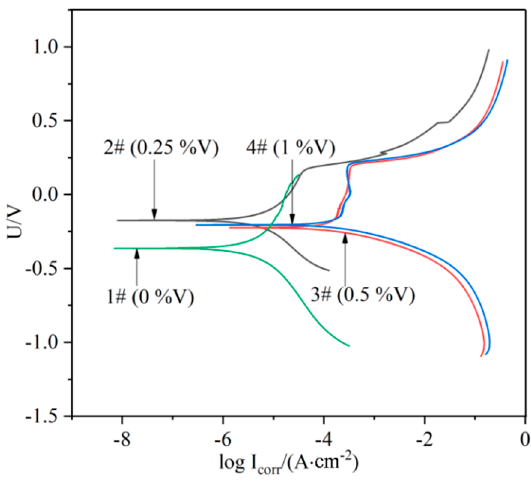
Figure 9. Polarization curves of the laser cladding layers with di ff erent V contents. Table 3. Electrochemical corrosion parameters of the laser cladding layers with di ff erent V contents.